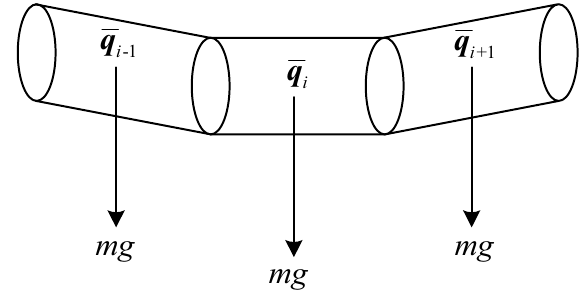
Figure 5. Element